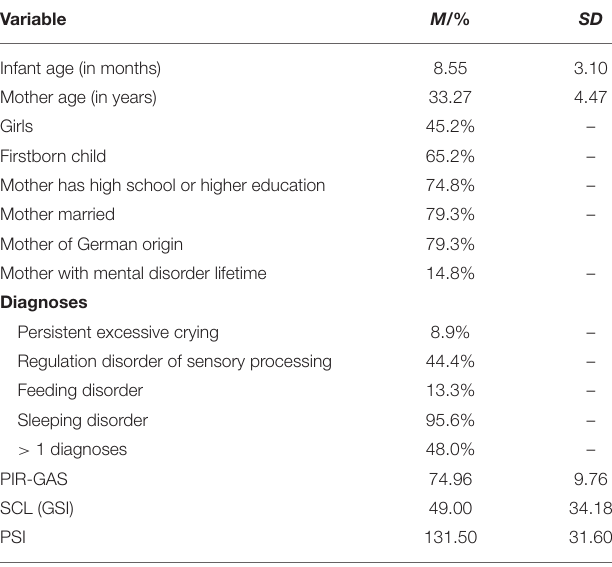
TABLE 1 | Sample characteristics of infants and their mothers ( N =